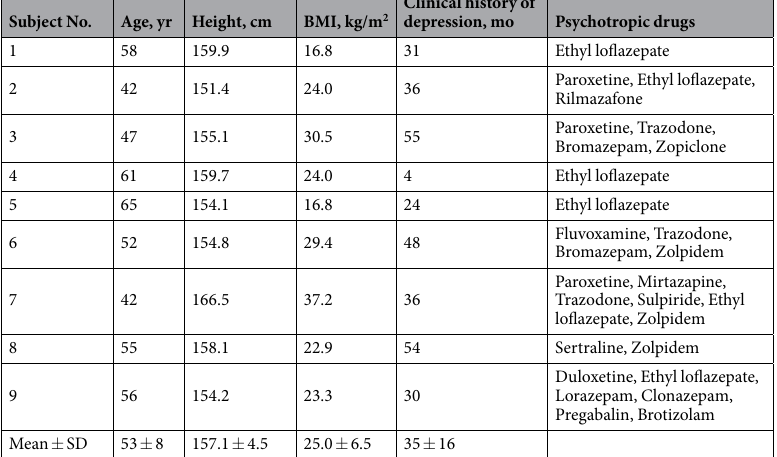
PLC ALA + SFC Before After Before After Body weight, kg